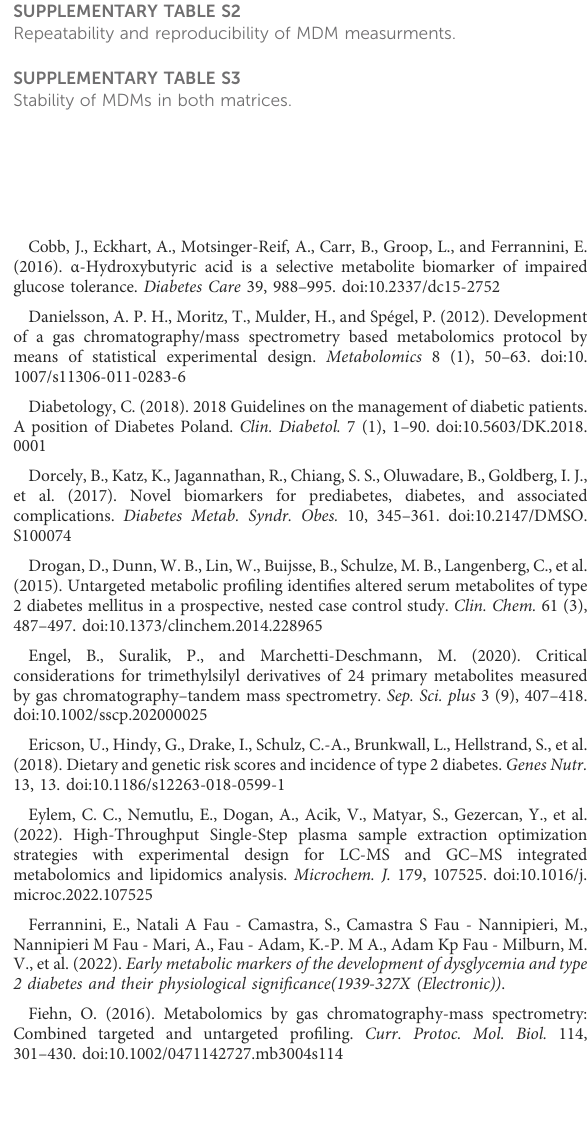
SUPPLEMENTARY TABLE S1 List of MDMs considered for optimization. rt, retention time; HMDB-